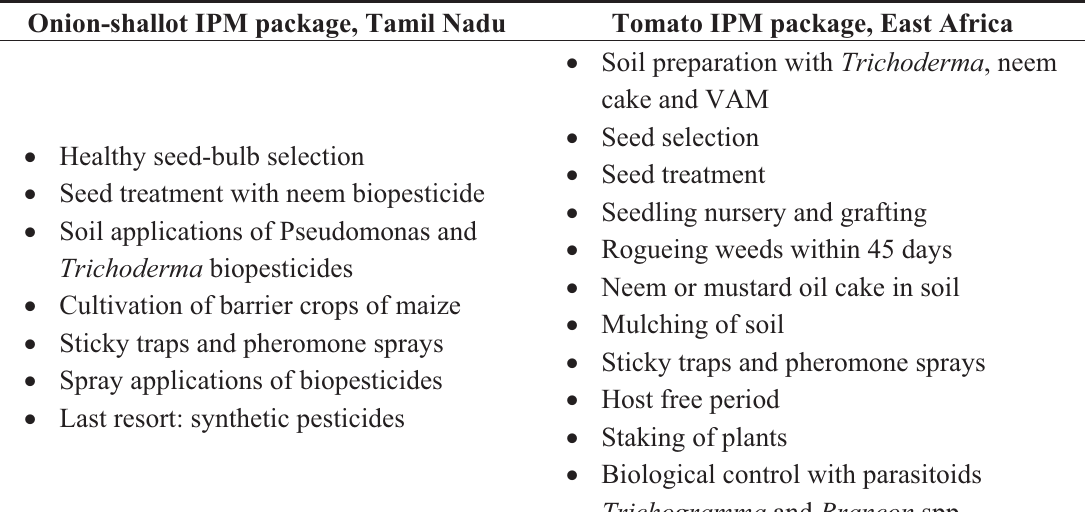
Table 7. Components of two IPM packages for onion-shallots in India and green tomatoes in East Africa